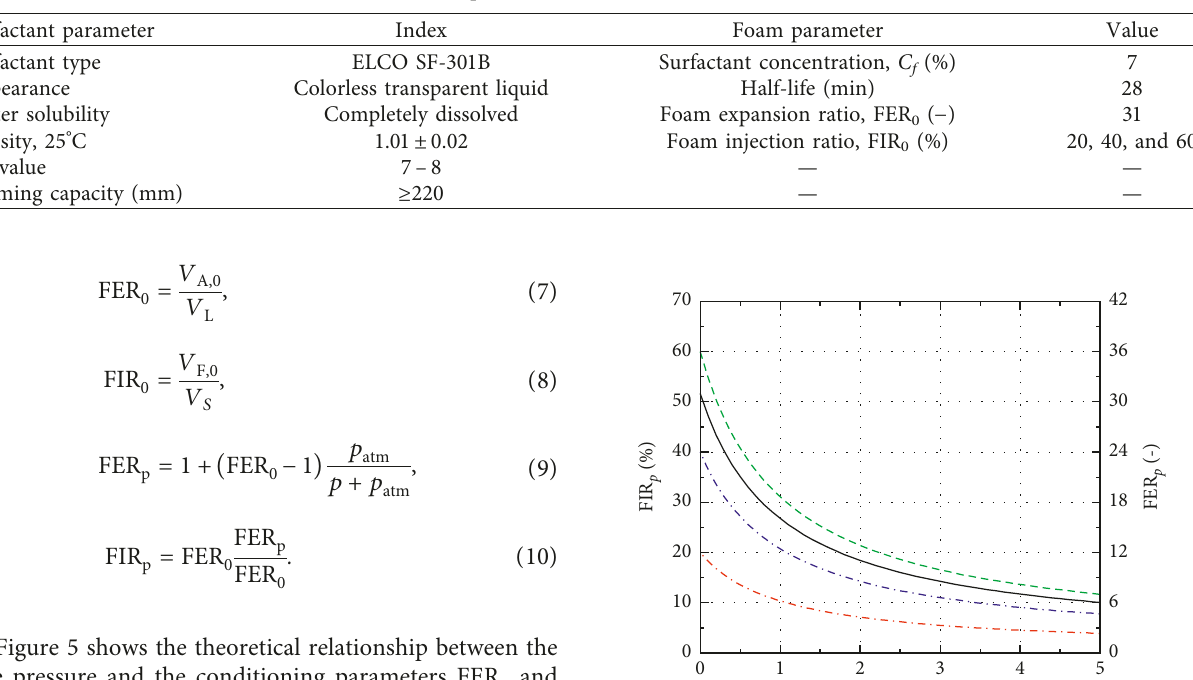
p and FER p with the pore